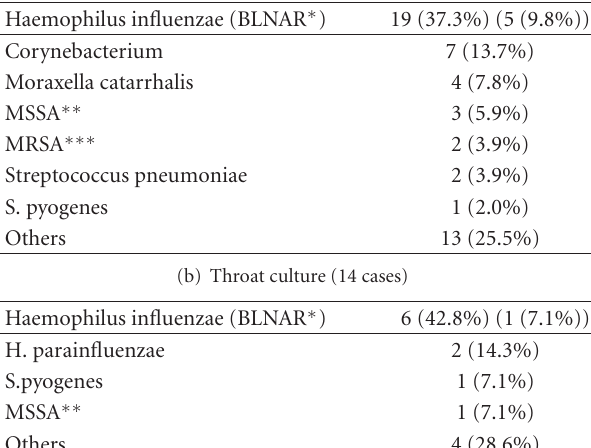
Table 2: The results of nasal cavity culture and throat